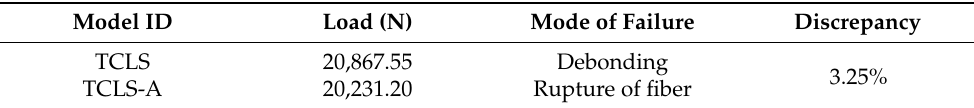
Figure 13. Anchored Double Shear Model (TCLS-A) Table 4. Comparison of direct shear test models with and without anchorage. Table 4. Comparison of direct shear test models with and without anchorage.